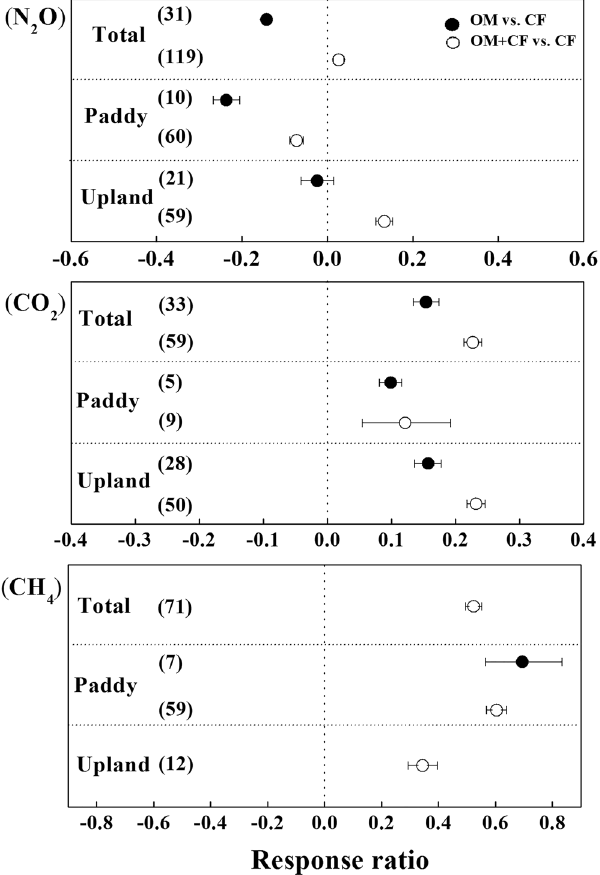
Figure 3. N 2 O, CO 2 and CH 4 emissions (CH 4 emission for paddies and uptake for upland) affected by manure application (OM + CF and OM) compared to Min-F respectively. P < 0.05, when error bars do not overlap